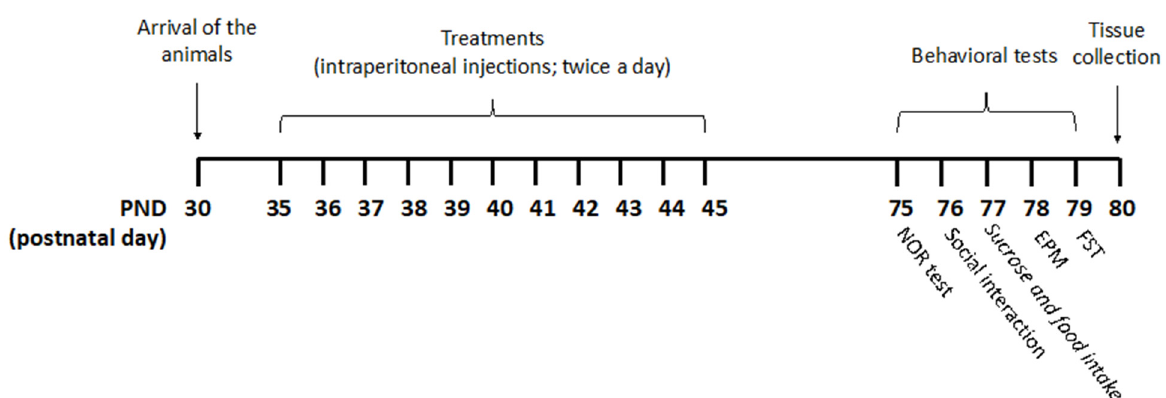
Figure 5. Treatment schedule. Rats received pure THC, THC/CBD combinations, or vehicle twice a day via intraperitoneal (i.p.) injections during the adolescent period from postnatal day (PND) 35 to PND 45. THC/CBD ratios of 3 and 0.33, reminiscent of THC-rich/CBD-poor and CBD-rich/THC-poor cannabis, respectively, were used. For the CBD-rich/THC- poor combination, a THC content of 0.3% was considered. Animals were divided into four experimental groups: vehicle (ethanol: Kolliphor: saline 1:1:18); pure THC (2.5 mg/kg—PND 35–37; 5 mg/kg—PND 38–41; 10 mg/kg—PND 42–45); THC-rich/CBD-poor (THC 2.5 mg/kg + CBD 0.83 mg/kg—PND 35–37; THC 5 mg/kg + CBD 1.66 mg/kg—PND 38–41; THC 10 mg/kg + CBD 3.32 mg/kg—PND 42–45); CBD-rich/THC-poor (THC 0.15 mg/kg + CBD 5 mg/kg). Starting from PND 75, rats underwent behavioral assessment on five consecutive days. Twenty-four hours after the last test, brain tissues were collected for subsequent biochemical analysis.